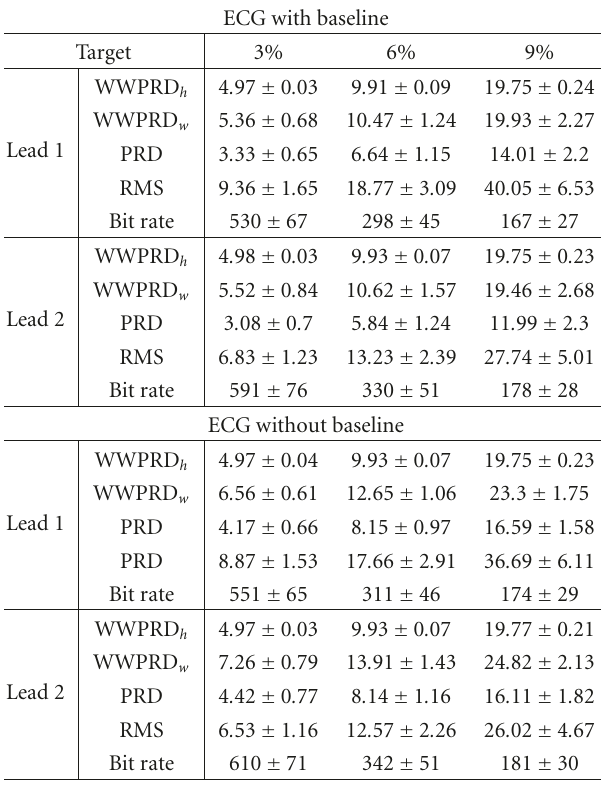
Table 2: Results when guaranteeing WWPRD w in MIT-BIH Ar- rhythmia. (WWPRD w , WWPRD h , and PRD expressed in %, RMS expressed in μV and bit rate in bps).